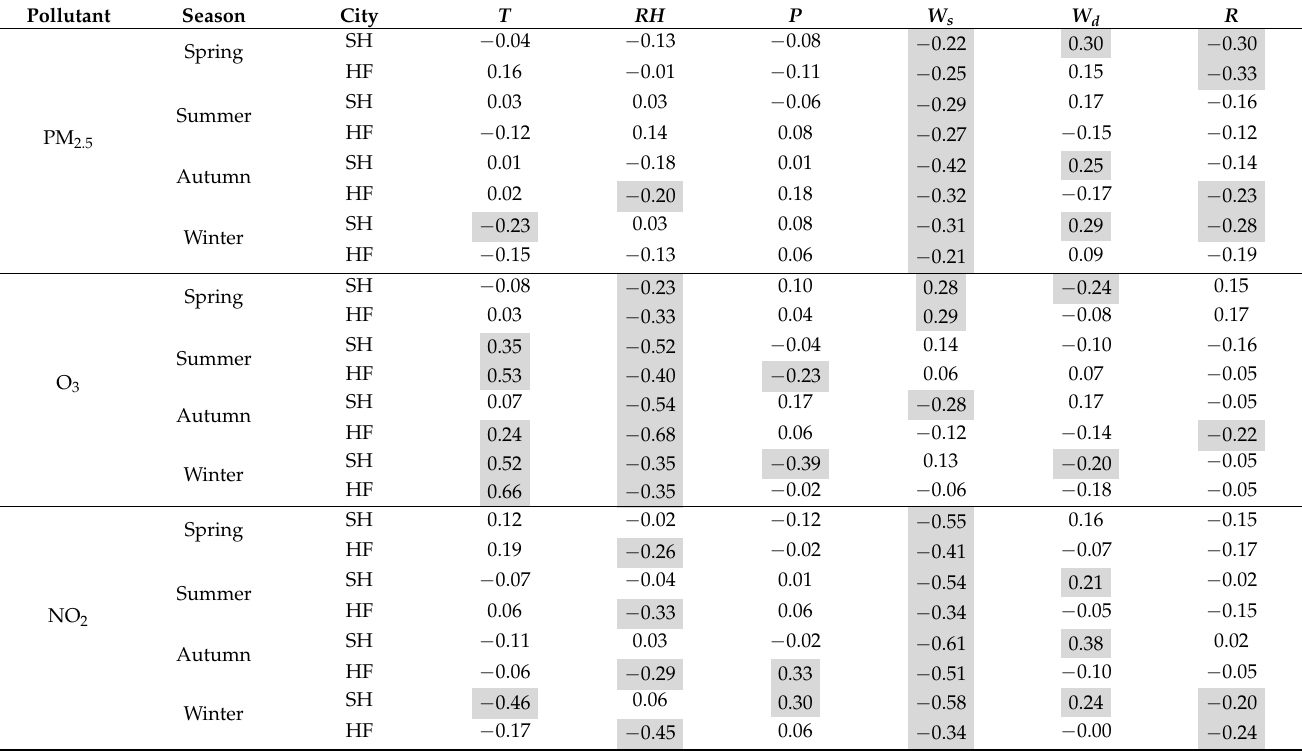
Table 2. Correlation coefficients from linear regression relationships between daily mean PM 2.5 , O 3 , and NO 2 concentrations and meteorological parameters, i.e., temperature ( T) , relative humidity ( RH) , pressure ( P) , wind speed ( W s ), wind direction ( W d ) , and rainfall ( R ), in different seasons in Shanghai (SH) and Hefei (HF). The correlation coefficients for the confidence levels of 0.05 and 0.01 are ± 0.20 and ± 0.25, respectively, given that the number of samples is much greater than 100 for all correlations. Significance values at p < 0.05 are shaded.